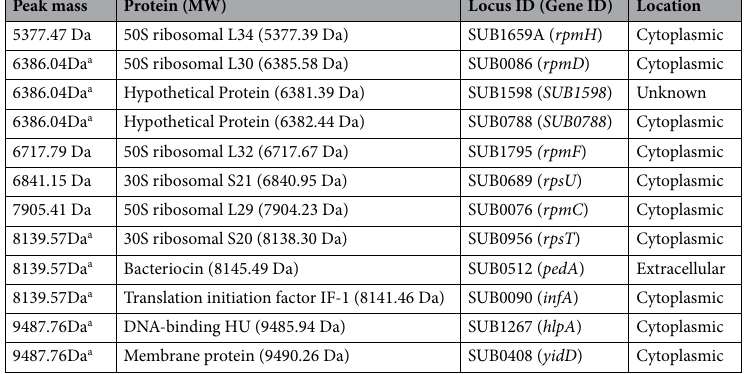
Table 4. MALDI-TOF peak masses and their cognate S. uberis proteins. a Peaks having more than one protein matches based on criteria of 0.2% molecular weight distance range from the peak